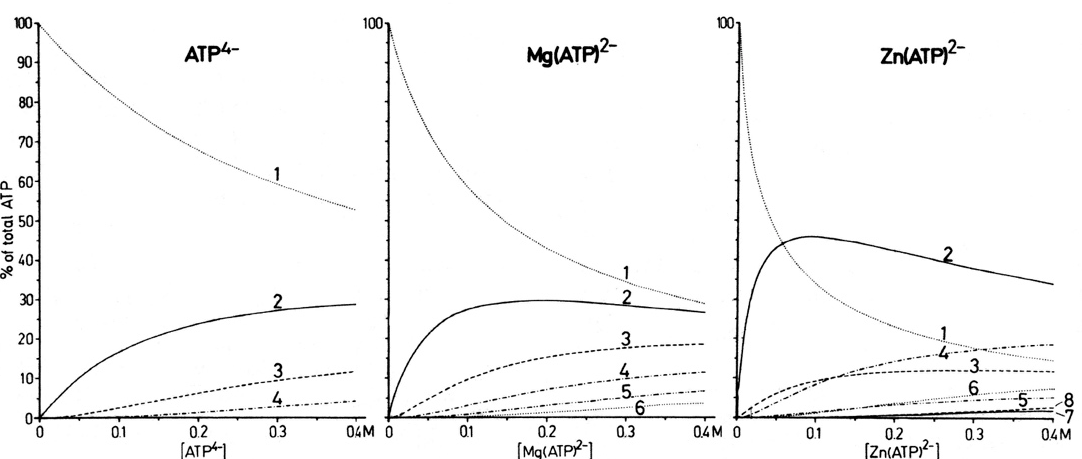
Figure 9. Variation in the proportions of ATP present in the monomer (1), dimer (2), trimer (3), …, and octamer (8) in D 2 O solutions in dependence on the total concentration of ATP 4 − ( K = 1.3 M − 1 ), Mg(ATP) 2 − ( K = 4.0 M − 1 ), and Zn(ATP) 2 − ( K ∗ = 20 M − 1 and K st = 4 M − 1 ) (see text in Section 6.2 and Equations (18)–(20)) (27 ◦ C, I = 0.1 to ~2 M (NaNO 3 ) in D 2 O). This figure is reproduced